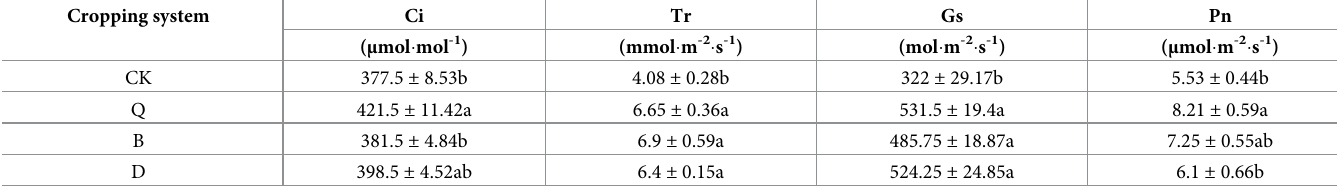
CK: Continuous tomato cropping; Q: Celery/tomato rotation; B: Cabbage/tomato rotation; D: Kidney bean/tomato rotation; Ci: Intercellular CO 2 concentration; Tr: Transpiration rate; Gs: Stomatal conductance; Pn: Net photosynthetic rate. Different lowercase letters at each phenological stage indicate that the differences are statistically significant (P < 0.05).